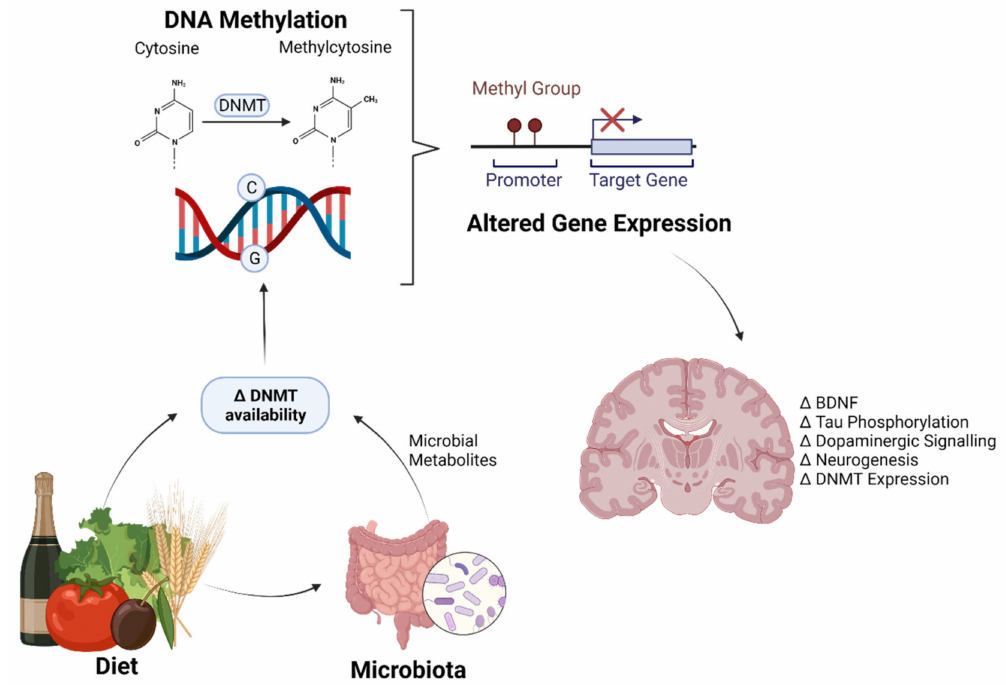
Figure 2. Diet and the gut microbiome regulate brain gene expression through epigenetics. An overview of how the diet and gut microbiome alter DNMT (DNA methyltransferase) availability, either through loss of cofactors/one-carbon molecules, or inhibition of DNMTs. This alters the methylation status of cytosine residues in DNA, which, when in promotor regions of genes, can prevent transcription. Genes commonly altered by the diet and microbiome that affect cognition include BDNF (brain derived neurotrophic factor), Tau, dopamine-related genes, neurogenesis-related genes and DNMTs themselves. Created with